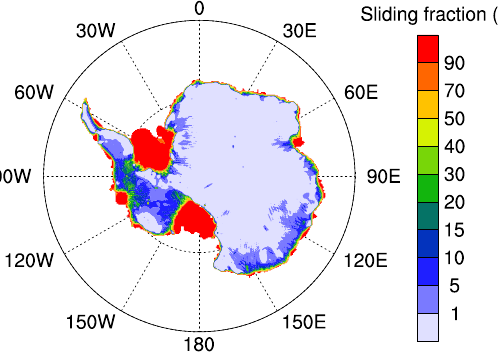
Fig.4. Thefractionofslidingvelocity( V SSA / V tot )withrespect tothetotalverticallyaveragedicevelocityatthePDfortherefer- Figure 4. The fraction of sliding velocity ( V SSA / V tot ) with respect encesimulation( φ min =10). to the total vertically averaged ice velocity at the PD for the refer- ence simulation ( φ min = 10 ◦